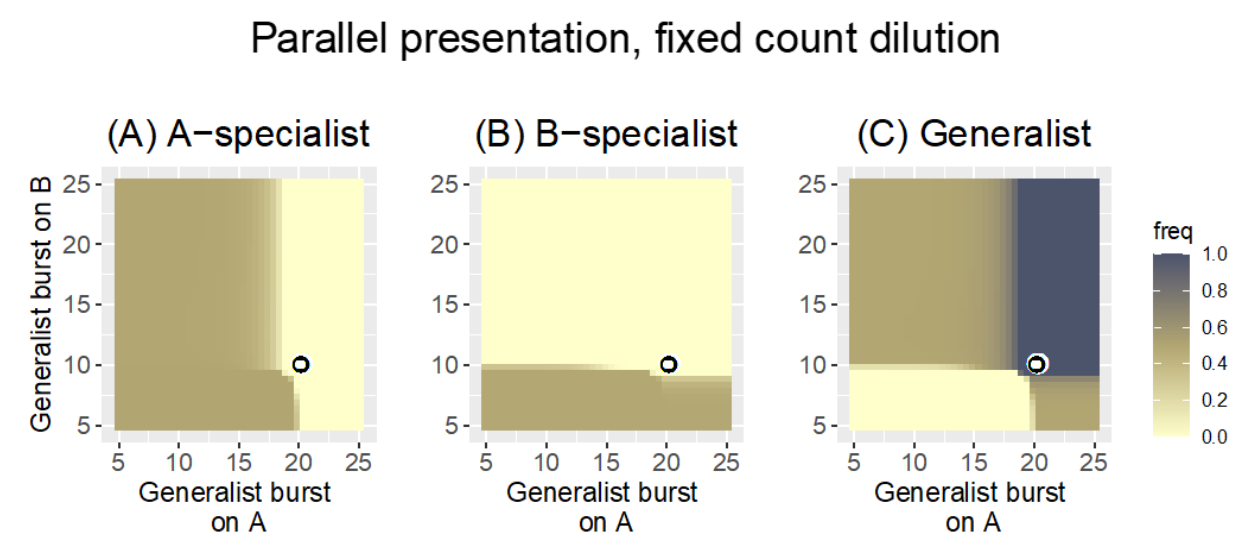
Figure 3. Heat maps of Parallel presentation with unequal burst sizes of the two specialists ( b A|A = 20, b B|B = 10, as indicated by the coordinates of the black-on-white ring). The three panels show the frequency of the A-specialist ( A ), the B-specialist ( B ), and the generalist ( C ). As in Figure 2, the generalist is maintained on either or both hosts according to whether its burst size exceeds that of the specialist on that host, and there are large zones in which two phages are maintained. Each panel shows, for the phage indicated in the title, its frequencies at time 1000 based on generalist and specialist burst sizes. Each specialist is lost when the generalist burst size exceeds that of the specialist on that host. The generalist is lost only when its burst sizes are less than those of the respective specialists on both hosts. Again, Parallel presentation is a ‘fair’ arbiter of phage retention, and again, there is a slight advantage to being a generalist in that the generalist displaces the specialist even when the generalist bursts are each slightly less than that of the respective specialist. There is no obvious ‘tyranny’ of generalists on the good host here. However, a tyranny is not necessarily expected because the bacterial growth rate is so high (0.3) that the poor host (B) reaches a high density before the poor phage overwhelms it — resulting in a large N B|B despite its small burst. Bacterial growth rate is 0.3 and dilution reduces phage density to 1000 every 20 time steps. The key is the same as in Figure 2.